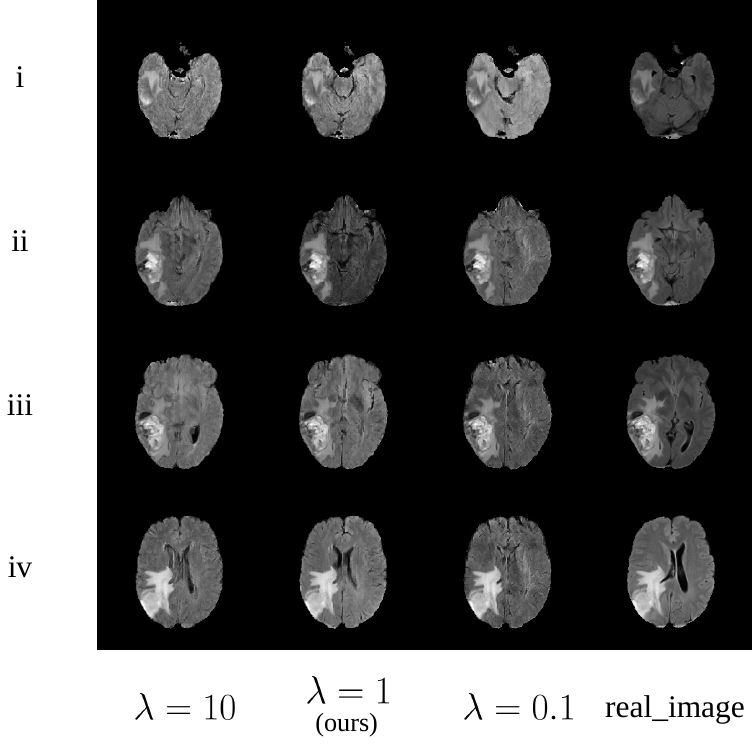
Figure 9. The synthetic image examples using different λ